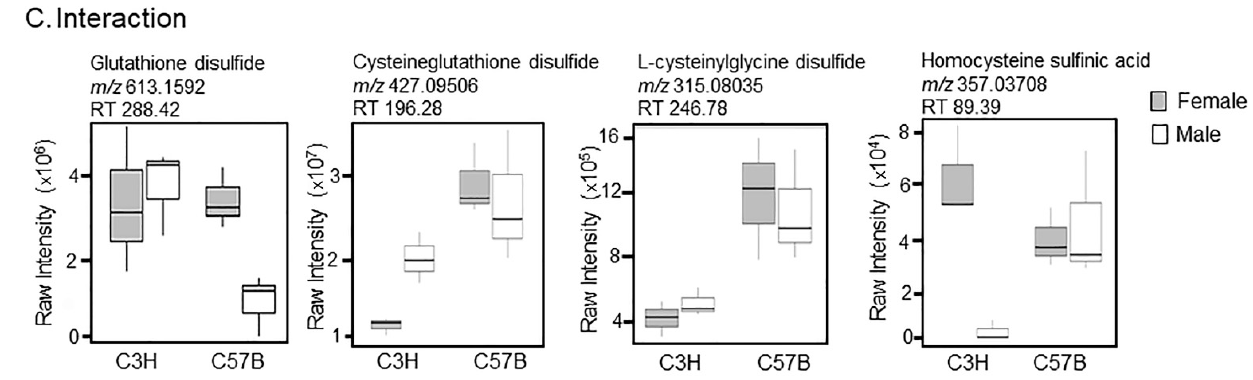
Figure 2. Metabolites identified within the methionine, cysteine, and selenocysteine pathways. Selected metabolites which differed between ( A ) strain, ( B ) sex, and ( C ) interaction were plotted.